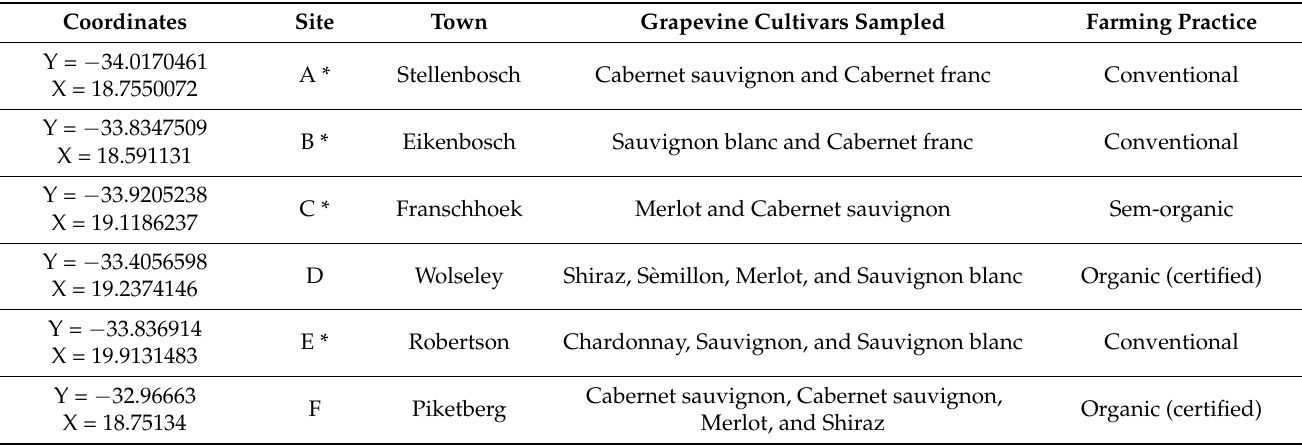
Table 1. The coordinates of sampled vineyards in the Cape Winelands, the location, the sampled grapevine cultivars, and the farming practices. Coordinates Site Town Grapevine Cultivars